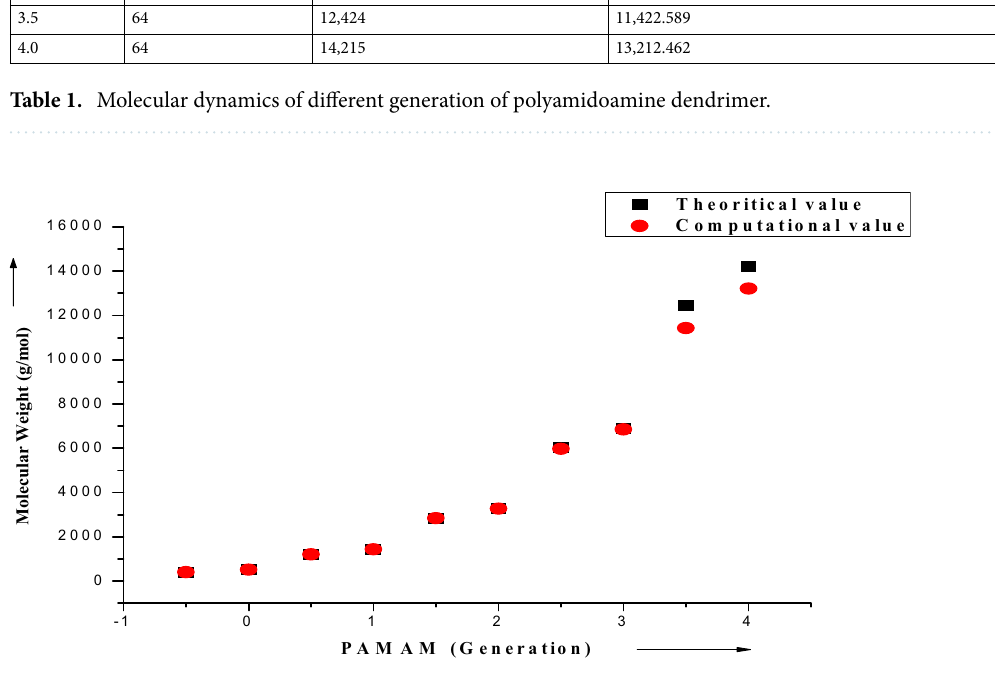
Figure 3. Graphical plot showing alter in molecular weight obtained from theoretical and computational studies of dendrimers (OriginPro 8 SR0, v8.0724 (B724), OriginLab Corporation: http://www.Origi